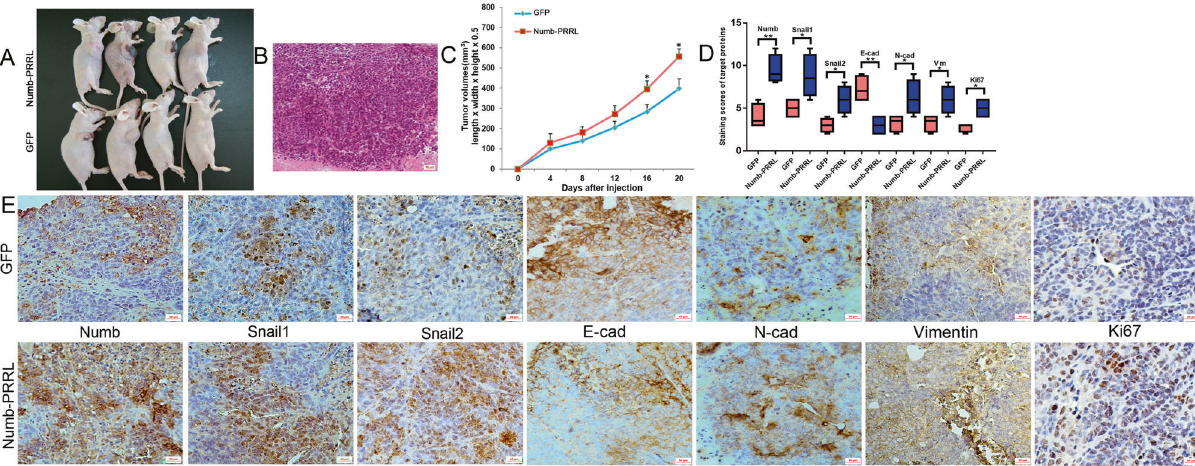
Fig. 6 Numb-PRRL overexpression promoted subcutaneous tumors formation in vivo. A Tumor volumes in the Numb-PRRL and GFP groups implanted with PANC-1 cells. B HE staining of harvested tumor. C Tumor growth curve in Numb-PRRL and GFP groups. D The statistic data of IHC assays. E The different expression levels of Numb, Snail1, Snail2, E-cad, N-cad, Vimentin, and Ki67 in the Numb-PRRL and GFP groups by IHC. Bars indicate ±S.E. * P < 0.05; ** P < 0.01 compared with control.